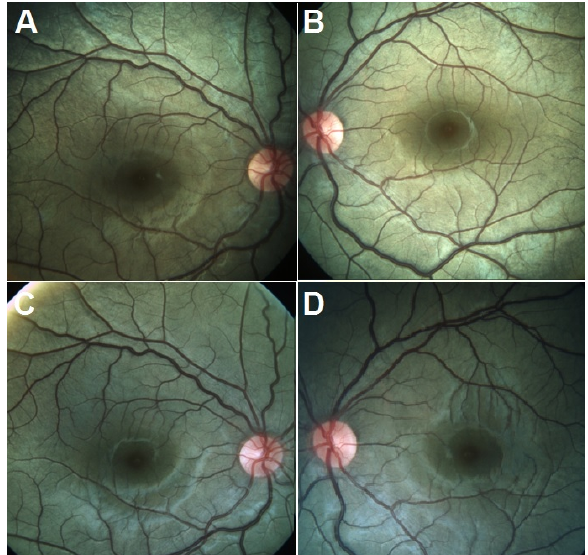
Figure 1: Fundus photos of the right (A) and left (B) eye reveal a golden sheen caused by the Mizuo-Nakamura phenomenon. The golden sheen is extinguished after 45 minutes of dark adaptation as seen in the fundus photos of the right (C) and left (D)